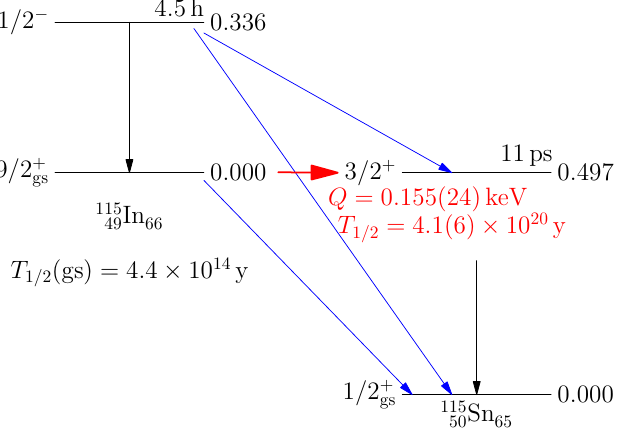
Figure 1. β − -decay transitions from the ground state of 115 In to the ground state and first excited state in 115 Sn. The numbers to the right of the energy levels are excitation energies in